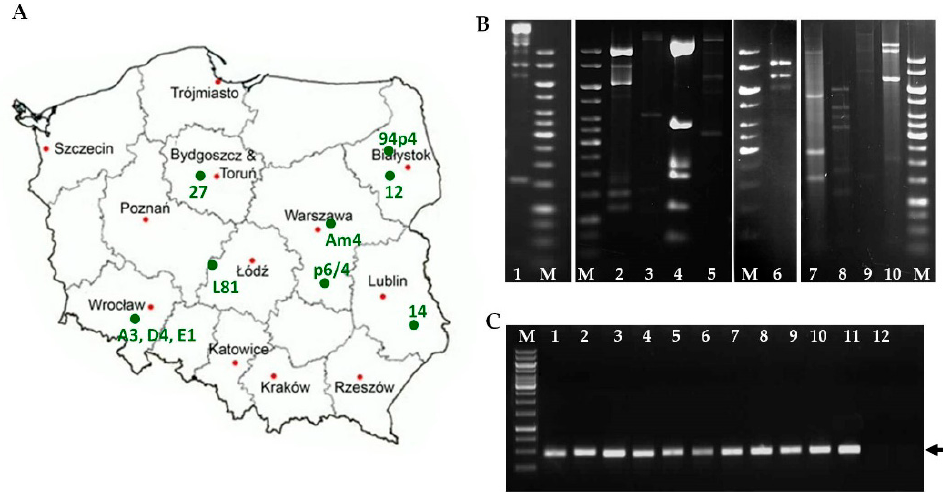
Figure 1. Geographical distribution, restriction fragments length polymorphism (RFLP) and PCR analysis of Ceduovirus phages. ( A ) Map shows the geographical site of isolation of each individual phage. ( B ) Restriction fragments length polymorphism (RFLP) analysis of Ceduovirus phages using the EcoRV enzyme. DNA samples were digested o/n at 37 °C with EcoRV . To dissociate cos ends prior to electrophoresis 50% formamide was